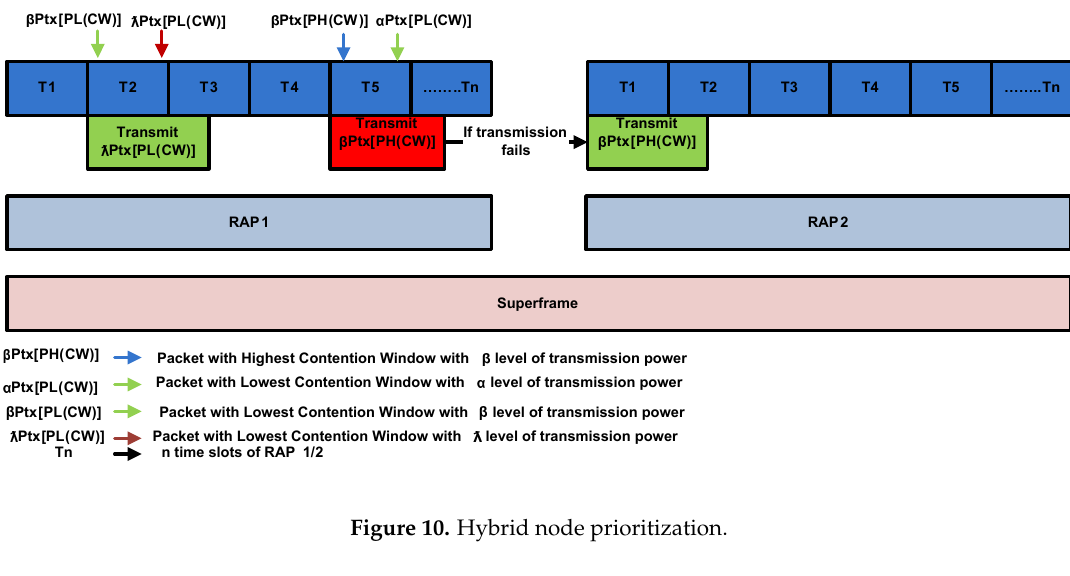
Figure 10. Hybrid node